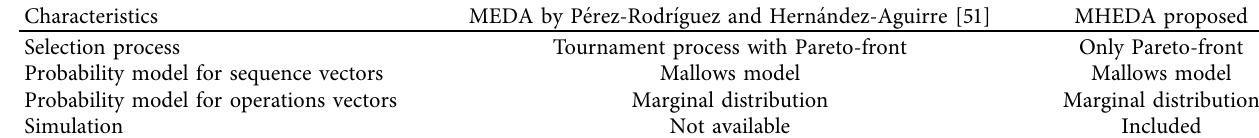
Table 8: Main differences and similarities between MHEDA and MEDA.